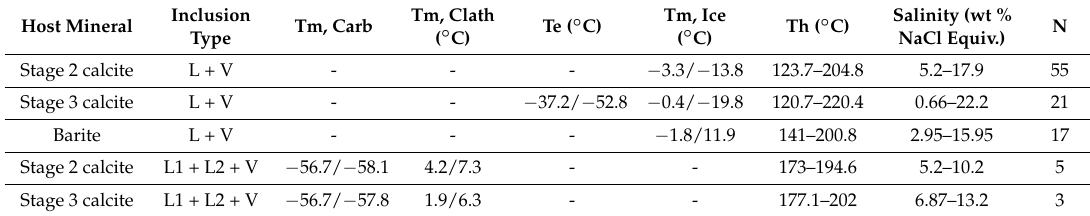
Table 1. Summary of microthermometric data of the Ravanj deposit [16].